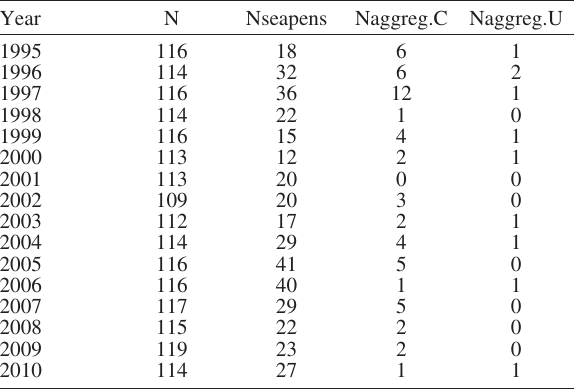
Table 1. – Summary of the collection data from 1995 to 2010. N, number of hauls analysed; Nseapens, number of hauls with seapens; Naggreg.C, number of hauls with densities at or above the threshold 10.5 sea pens/haul on the circalittoral; Naggreg.U, number of hauls with densities at or above the threshold 10.5 sea pens/haul on upper